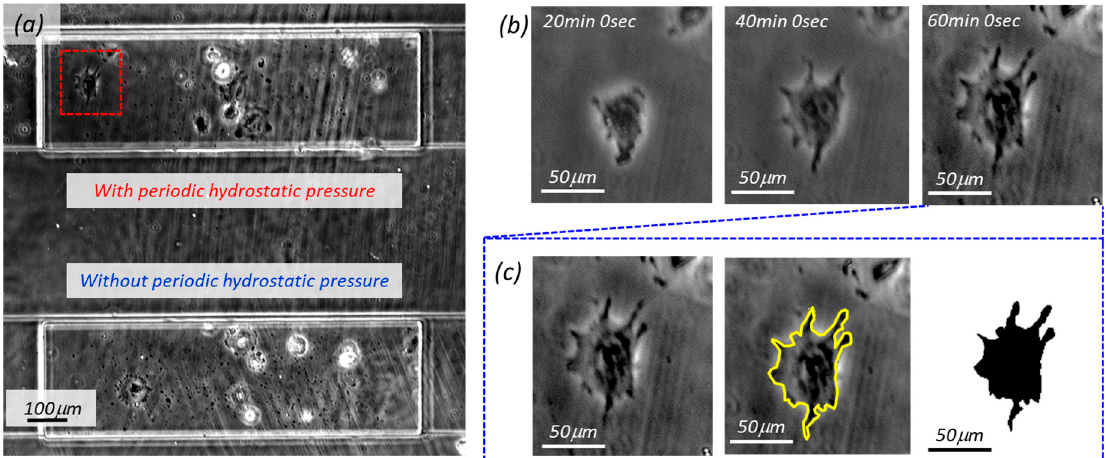
Figure 3. Captured pictures by time-lapse imaging. ( a ) Captured microscopic image where the chambers on the top and the bottom are the cells cultured with and without the proposed periodic hydrostatic pressure, respectively. An example of cell assessment is demonstrated using the highlighted cell. ( b ) Selected time-lapse images of the cell at the time of 20, 40, and 60 min. ( c ) The procedure to obtain the extracted cell area.